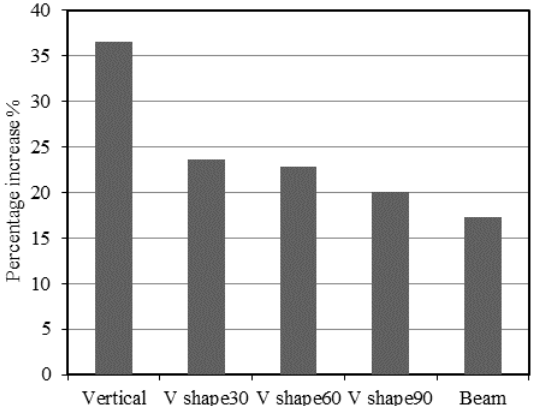
Figure 19. Percentage increase in the ultimate loads of FRC specimens compared to the corresponding NRC specimens.